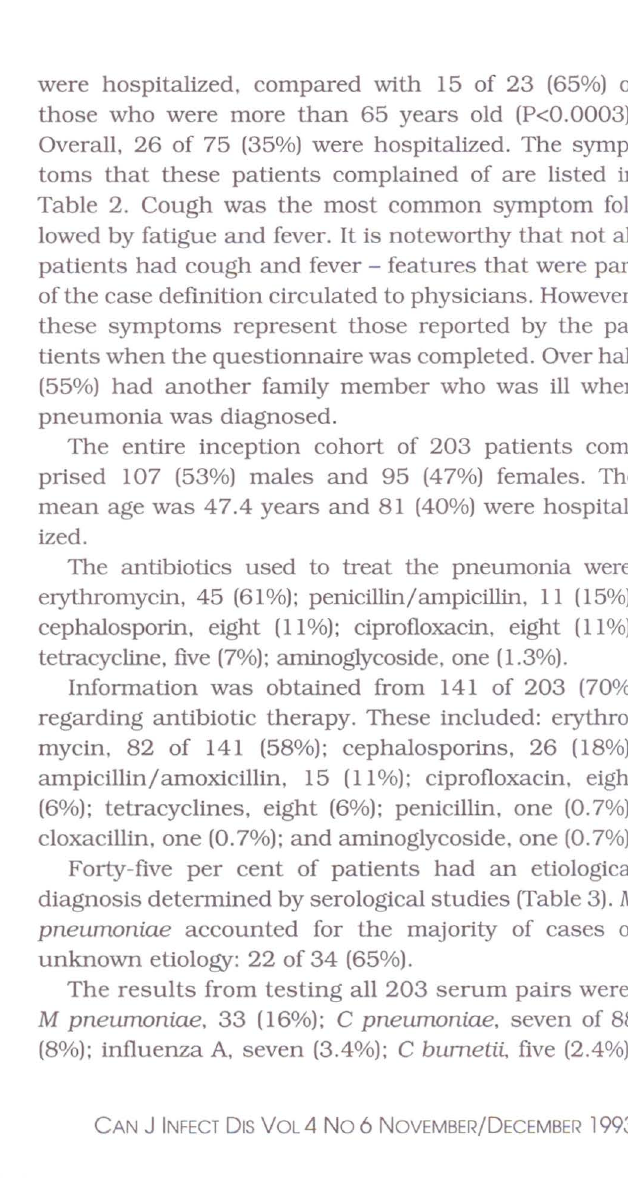
Figure 1) Month of onset of pneumonia for 75 patients. The number of patients with pneumonia due to each of the indicated agents is also shown. Chl Chlamydia pneumoniae; Inf A Influenza A virus; Adenov Adenovirus; Leg Legionella pneumophila; QF Coxiella bumetii- Qfever; MPNMycoplasma pneumoniae: dx Diagnosis: the clear space represents the number of patients who had no antibody rise to the agents indicated